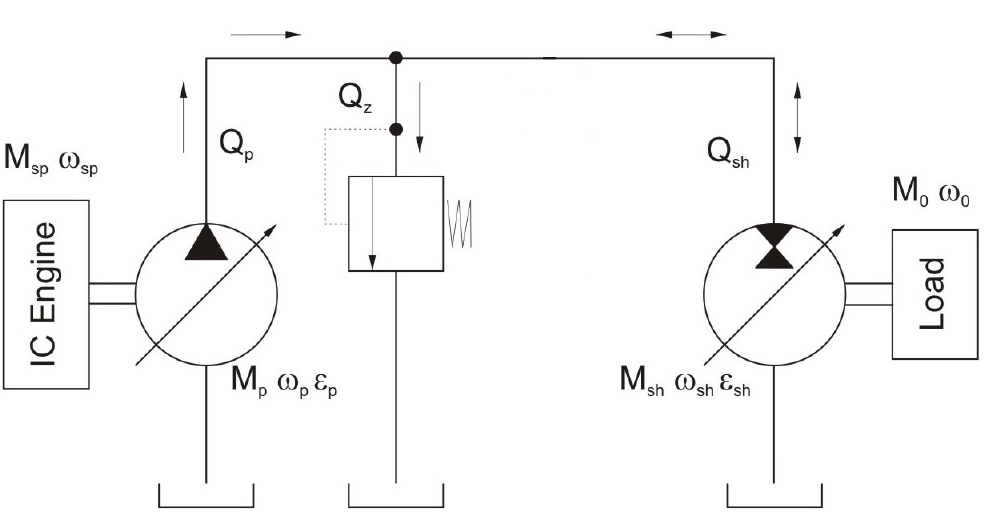
Figure 3. Schematic diagram of hydrostatic transmission ( M : torque; ω : angular velocity; Q : flow ratio; (cid:101) : hydrostatic unit control; indexes: sp : IC engine; p : hydrostatic pump; sh : hydrostatic motor; 0: load; z : flow through overflow valve)